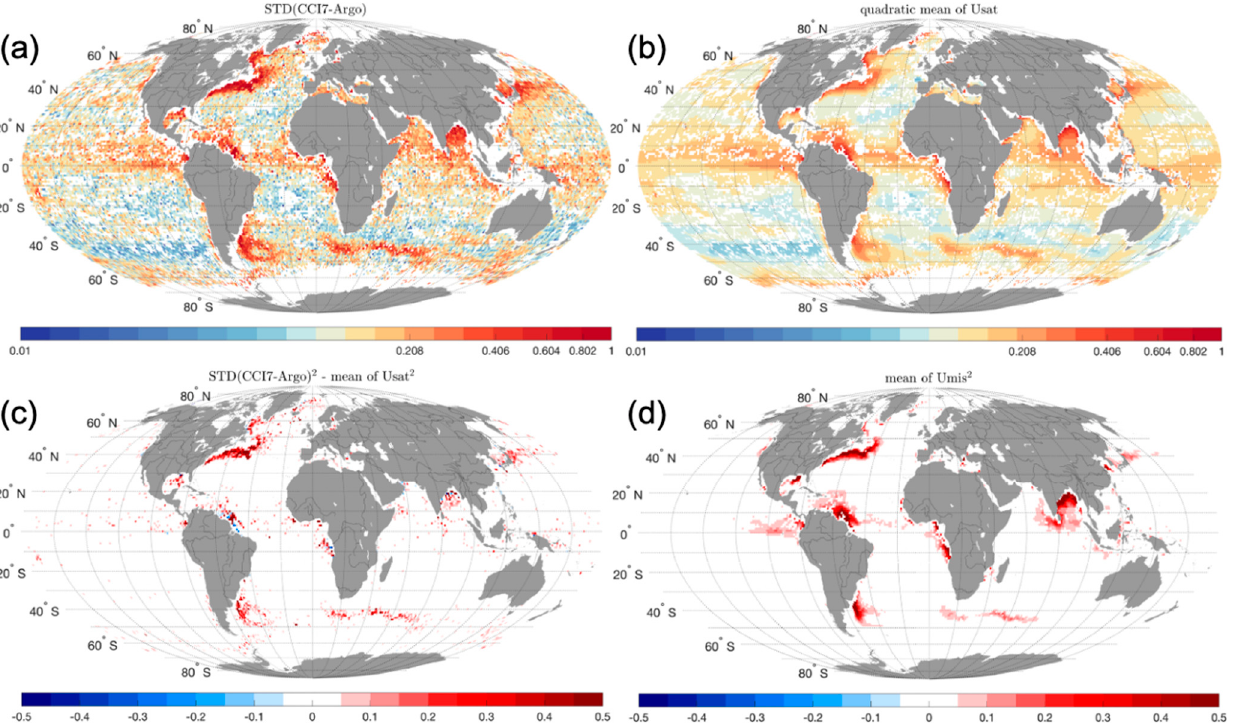
Figure 3. Terms of Equation (1) integrated for 2016–2018: ( a ) observed STD of the differences between weekly CCI and Argo salinity; ( b ) quadratic mean of U sat ; ( c ) the difference of squared terms shown in ( a , b ), STD 2 (CCI7-Argo)—mean (U sat2 ); and ( d ) quadratic mean of U mis . The statistics are reported in 1° boxes containing at least 3 Argo measurements (boxes in Figure 3a,b with less than 3 measurements are in white).